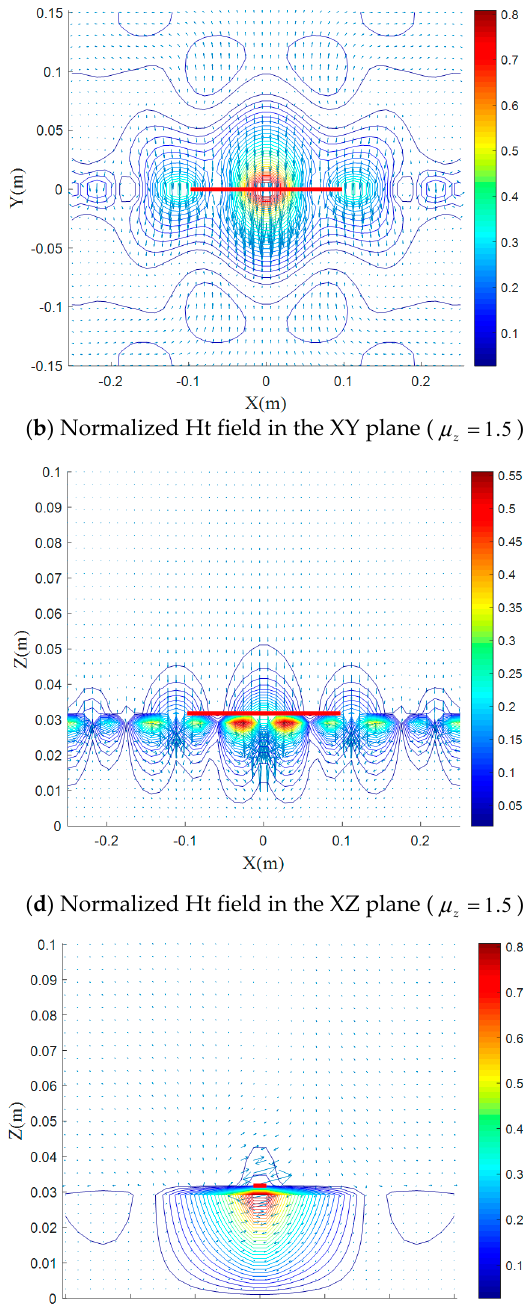
Figure 9. ( a – f ) Normalized electric field distributions for various values of XZ, and YZ planes.